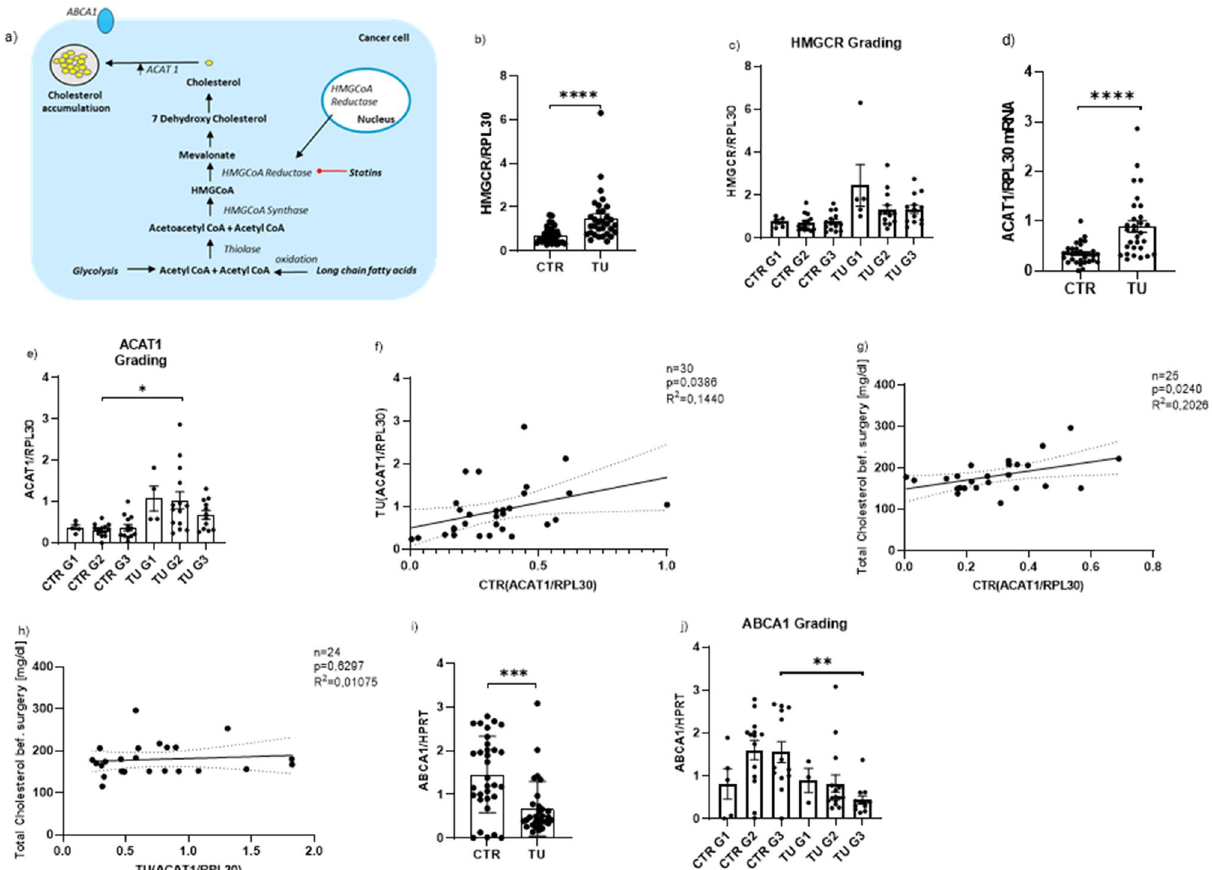
Figure 5. Increased cholesterol biosynthesis pathway in lung cancer cells caused by the overexpression of HMGCR and ACAT1 in the tumoral lung region of patients with LUAD and qPCR analysis of relative ACAT1/ RPL30, HMGCR/RPL30 and ABCA1/HPRT mRNA expression level in patients with LUAD. ( a ) Cholesterol biosynthesis pathway and the accumulation of cholesterol caused by an overexpression of ACAT1 in cancer cells. ( b ) qPCR analysis of relative HMGCR/RPL30 mRNA expression level, measured in the control region and tumoral region of patients with LUAD (CTR:n = 33; TU: n = 32). ( c ) qPCR analysis of HMGCR/RPL30 mRNA expression level subdivided into tumor gradings (CTR G1: n = 5; CTR G2: n = 14; CTR G3: n = 14; TU G1: n = 5; TU G2: n = 14; TU G3: n = 13). ( d ) qPCR analysis of relative ACAT1/RPL30 mRNA expression level in patients with LUAD: control region (CTR) and tumoral region (TU). (CTR n = 32; TU n = 30, p (CTR vs. TU) = < 0.0001). ( e ) qPCR analysis of ACAT1/RPL30 mRNA expression level subdivided into tumor gradings (CTR G1:n = 5; CTR G2: n = 14; CTR G3: n = 13; TU G1: n = 4; TU G2: n = 14; TU G3: n = 12, p (CTR G2 vs. TU G2) = 0.0125). ( f ) qPCR analysis of relative ACAT1/RPL30 mRNA expression level measured in the control region correlated with relative ACAT1/RPL30 mRNA expression level measured in tumoral region of patients with LUAD (n = 30, p = 0.1440, R 2 = 0.0386). ( g ) qPCR analysis of relative ACAT1/RPL30 mRNA expression level measured in the control region (CTR) correlated with total cholesterol values of LUAD patients (n = 25, p = 0.240, R 2 = 0.2026). ( h ) qPCR analysis of relative ACAT1/RPL30 mRNA expression level measured in the tumoral region (TU) correlated with total cholesterol values of LUAD patients (n = 24, p = 0.6297, R 2 = 0.01075). ( i ) qPCR analysis of relative ABCA1/HPRT mRNA expression level, measured in the control region and tumoral region of patients with LUAD (CTR:n = 33; TU: n = 32). ( j ) qPCR analysis of ABCA1/HPRT mRNA expression level subdivided into tumor gradings (CTR G1:n = 5; CTR G2: n = 14; CTR G3: n = 13; TU G1: n = 3; TU G2: n = 14; TU G3: n = 12, p (CTR G3 vs. TU G3) = 0.0085). Correlations are shown by using simple linear regression. Paired t-test was performed for Figure b,d and i; Kruskal Wallis test was performed for Figure e and j. Data are shown as mean values ± s.e.m.; *P < 0.05; **P < 0.01***P < 0.001 ****P <